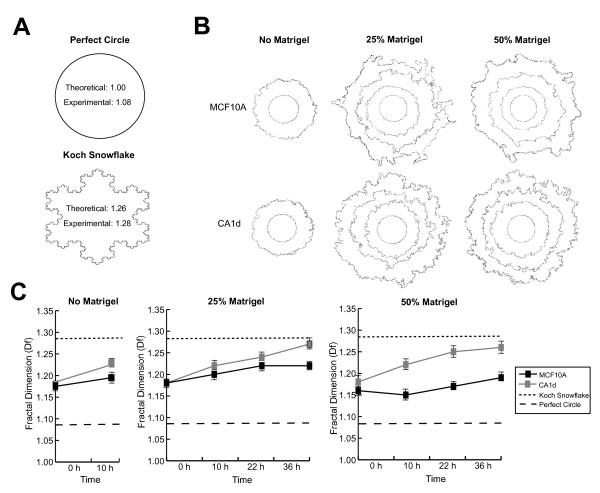
Fractal Analysis of MCF10A and CA1d Cell Lines. (A) Two simulated test patterns of known Df, a "perfect" 2-D circle and the "Koch snowflake", were used to validate the FracLac program, and to put our data into context within these controls. These patterns were normalized by pre-processing in the same manner as the contours of nests prior to fractal analysis, and resulted in measured values of 1.08 and 1.28, respectively. (B) Representative time-lapse images (0, 10, 22, 36 h) of MCF10A and CA1d cells taken in the absence or presence of 25% or 50% Matrigel overlay were thresholded to normalize background levels, and outlines were systematically applied to borders using a "define contours" function. Df measurements were then generated using the FracLac plugin. (C) All values are presented as the mean ± standard deviation of the fractal value for each nest captured at each time point of interest. Since NEA is highly standardized, all nests across both cell lines, and all treatments, had similar fractal measurements at 0 h. However, at all other time points measured after 0 h, the aggressive, invasive CA1d nests exhibited significantly greater Df measurements than the noninvasive MCF10A cell line (N = 8 per group; P < 0.01 in all cases), regardless of the microenvironment. Slopes calculated for lines fit to time-course data for CA1d Df values were approximately 2-fold greater than slopes for MCF10A nests, for all experimental conditions measured.